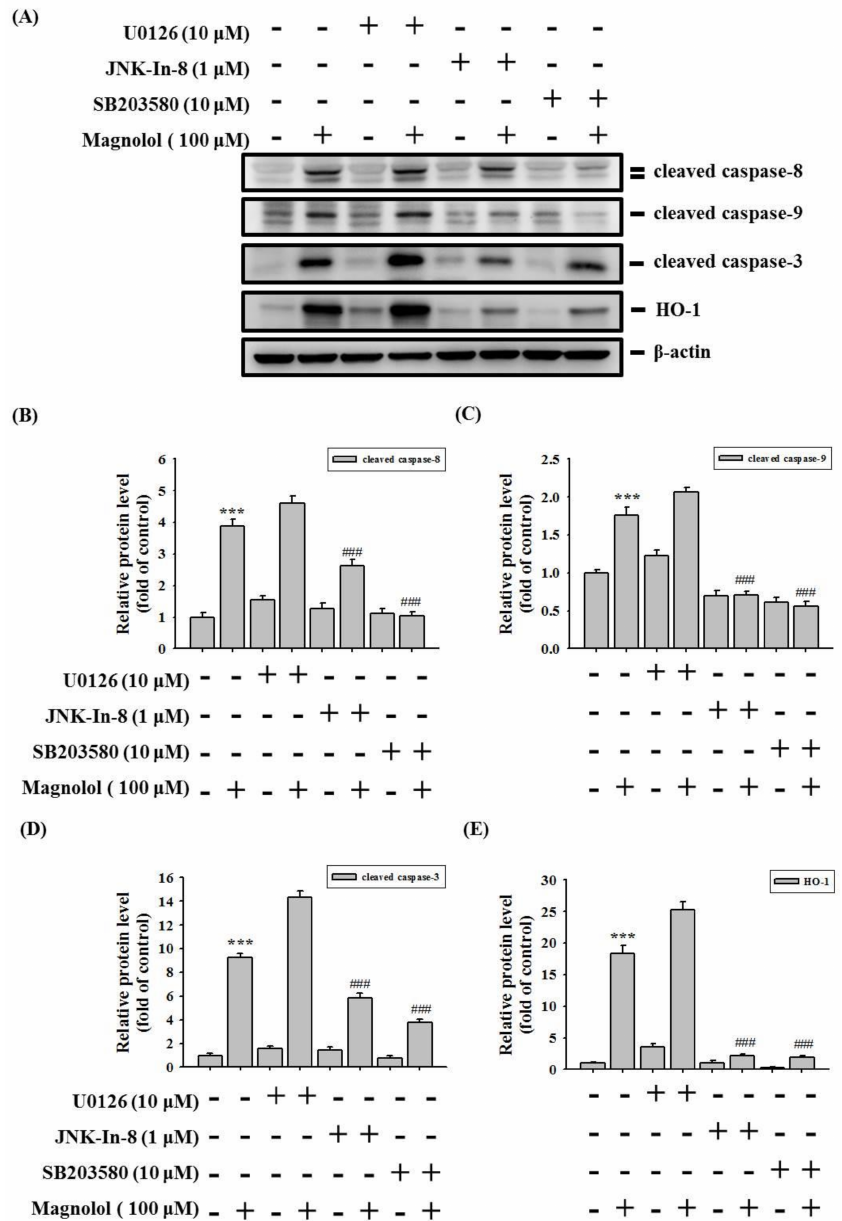
Figure 7. Magnolol induced caspase activation and HO-1 expression through JNK1/2 and p38 pathways in the HSC-3 cell line. ( A ) HSC-3 cells were pretreated with ERK1/2 inhibitor U0126 (10 µ M), JNK1/2 inhibitor JNK-IN-8 (1 µ M), or p38 inhibitor SB203580 (10 µ M) for 1 h and then treated with 100 µ M magnolol (100 µ M) for 24 h. The expressions of cleaved caspase-9, -8, and -3, and HO-1, were detected using Western blot analysis, as described in the Materials and Methods section. ( B – E ) Quantitative results of cleaved caspase-9, -8, and -3, and HO-1 protein levels, were adjusted for β -actin. The data represent the mean ± SD of three independent experiments. *** p < 0.005 compared with the control group. ### p < 0.05 compared with the magnolol alone treatment